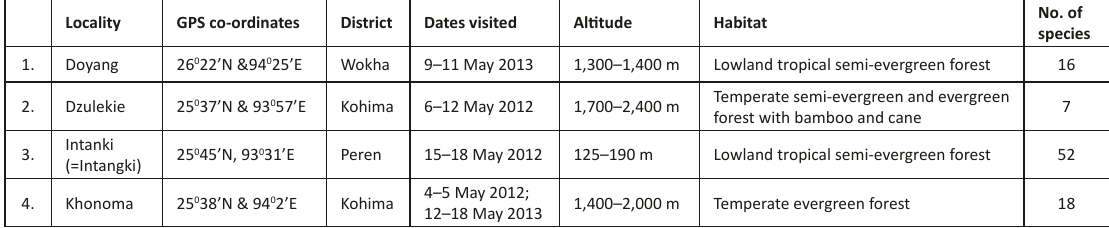
Table 2. Details of the voucher specimens mentioned in this paper, all deposited in the Research Collections Facility at the National Center for Biological Sciences, Bengaluru,